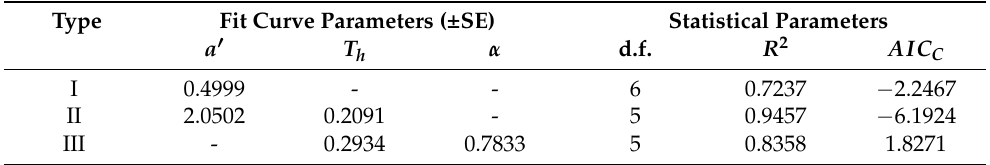
Table 4. Parameters and statistical significance for the functional response equations type I, II, and III when different densities of Tecia solanivora eggs were exposed to the adult female of Blattisocius tarsalis , during 24 h, under laboratory conditions. Type Fit Curve Parameters